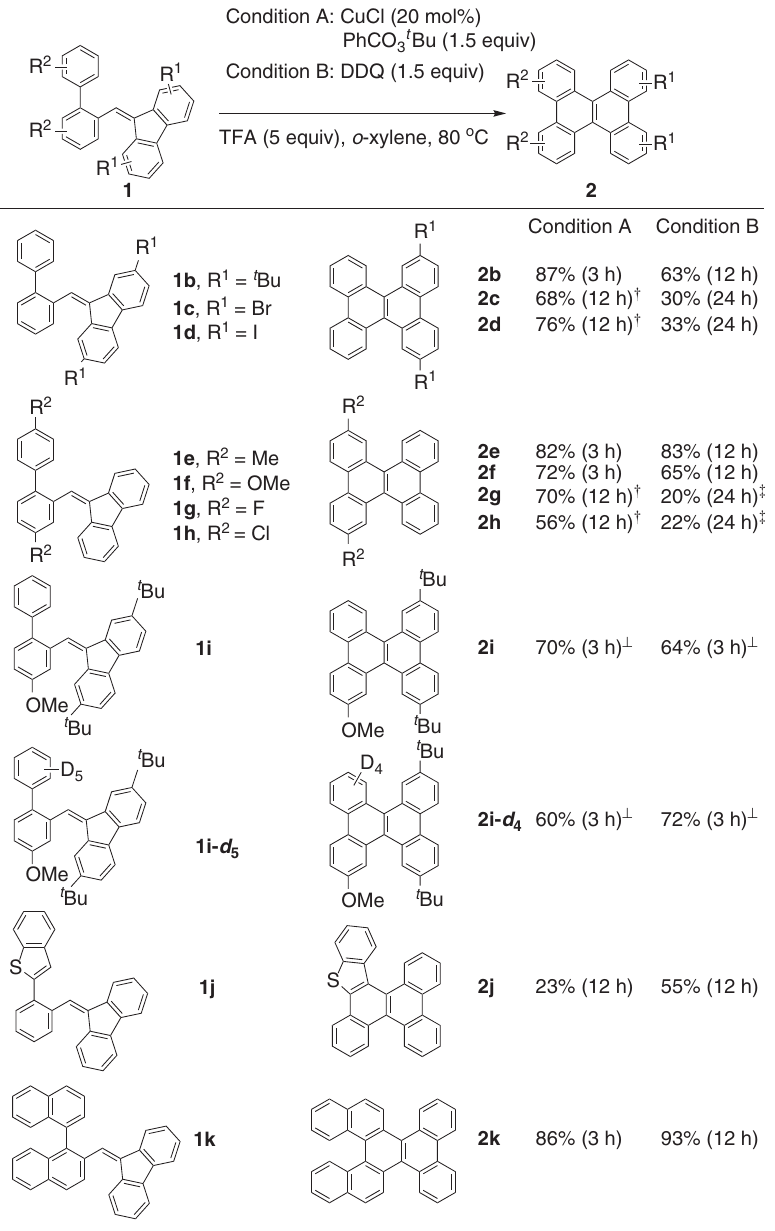
Figure 2 | Substrate scope of oxidative aromatization. The isolated yields are shown. w CuCl (40mol%), PhCO 3 t Bu (3 equiv) and TFA (10 equiv) were used. z DDQ (3 equiv) and TFA (10 equiv) were used. > The reaction temperature is 40 (cid:2)